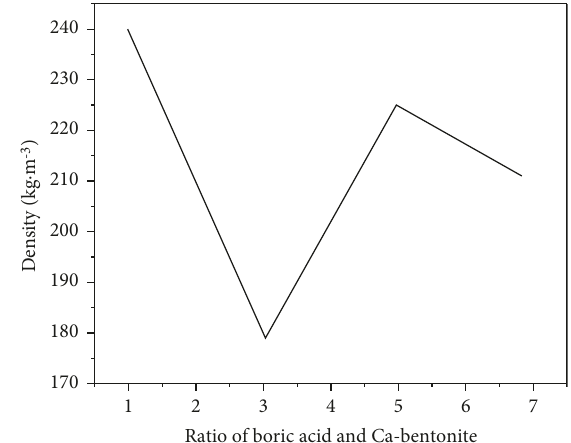
Figure 4: Variation diagram of low-temperature foam glass-ce- ramic composites obtained with different ratios of boric acid and Ca-bentonite.